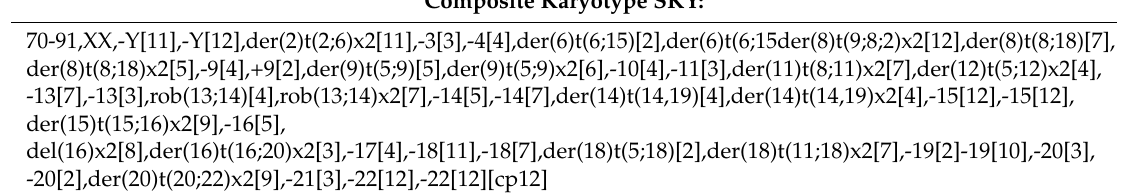
Table 1. Karyotype of the examined immortalized cell culture showing several aberrations in different chromosomes. SKY, spectral karyotyping.